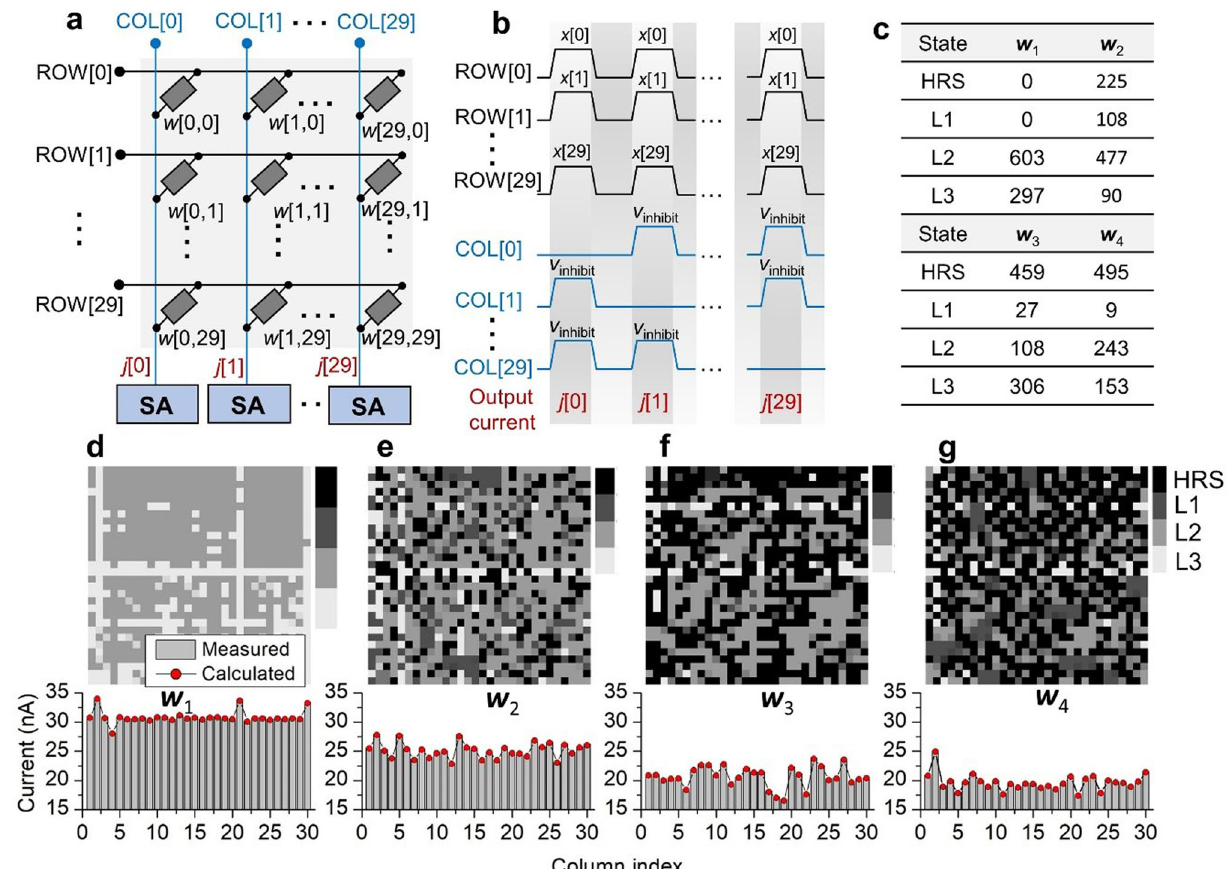
Fig. 8 Acceleration of vector-matrix multiplication using the 30 × 30 CA. a Con fi guration of a 30 × 30 matrix w mapped onto a CA of the same size. Vector x is encoded as voltage signals ( ‘ 0 ’ = 0 V, ‘ 1 ’ = 2 V) and enters into the row-lines (ROW[0] – ROW[29]). The resulting current vector j as an intermediate product enters into sense ampli fi ers (SAs) to be quantized. b Schematic timing diagrams of row- and column-line signals. The inhibit voltages applied to unchosen column-lines are denoted by V inhibit . c Statistics of four states (HRS, L1, L2, L3) in four random matrices (w 1 – w 4 ). d – g (upper panel) Conductance maps of the four random matrices (w 1 – w 4 ) and (lower panel) measured current vectors j for the four matrices. We considered a vector x of ones. The measurement results are compared with the calculated current vectors using the measured currents on individual